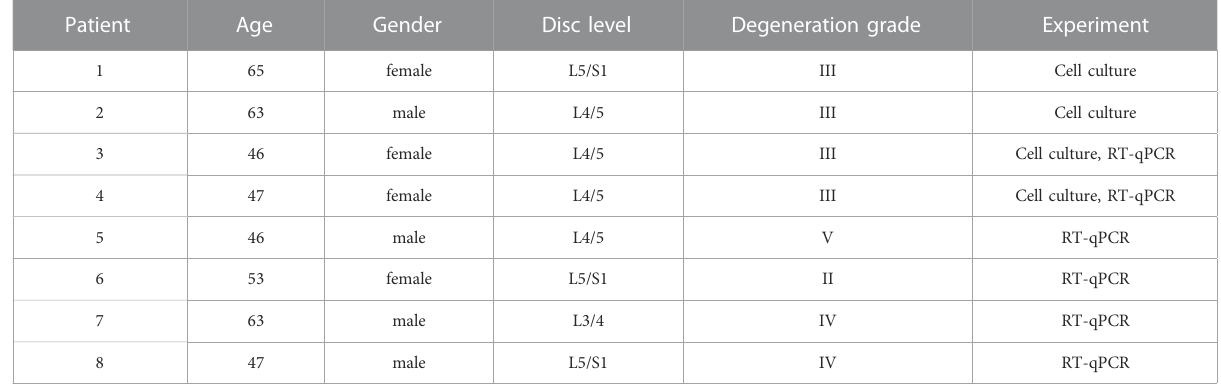
TABLE 1 Clinical patient